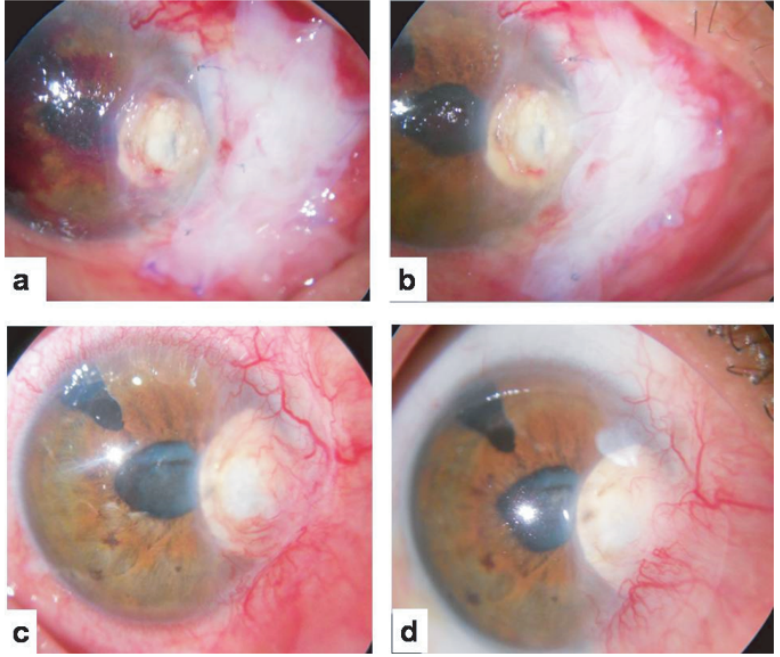
Figure 3. (a) Sealed corneal perforation 72 hr after surgery (scleral patch, CTA plug, and double layered AMG in place). (b) Corneal perforation sealed and corneo-limbo-scleral necrosis at healing stage at two-weeks’ follow-up. (c) Healed corneal perforation (sclera patch in place) and pseudo-pterygium at 12 weeks’ follow-up. (d) Healed corneal perforation (sclera patch in place) and pseudo-pterygium at 18 months’